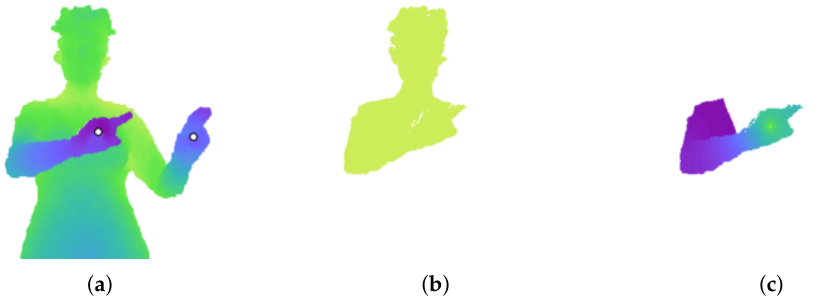
Figure 1. Effect of adding a dummy node. ( a ) Depth image. The white dots indicate the annotated hand pixels. ( b ) Probability values for the right hand, using the two hand pixels as seeds for the RW algorithm. The values are close to either zero or one. ( c ) Probability values after adding a dummy node to the graph. There is now a greater variance in the